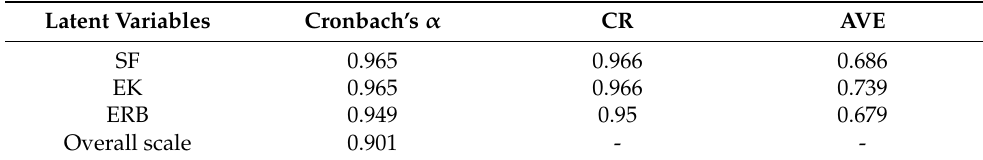
Table 2. Reliability of scale.